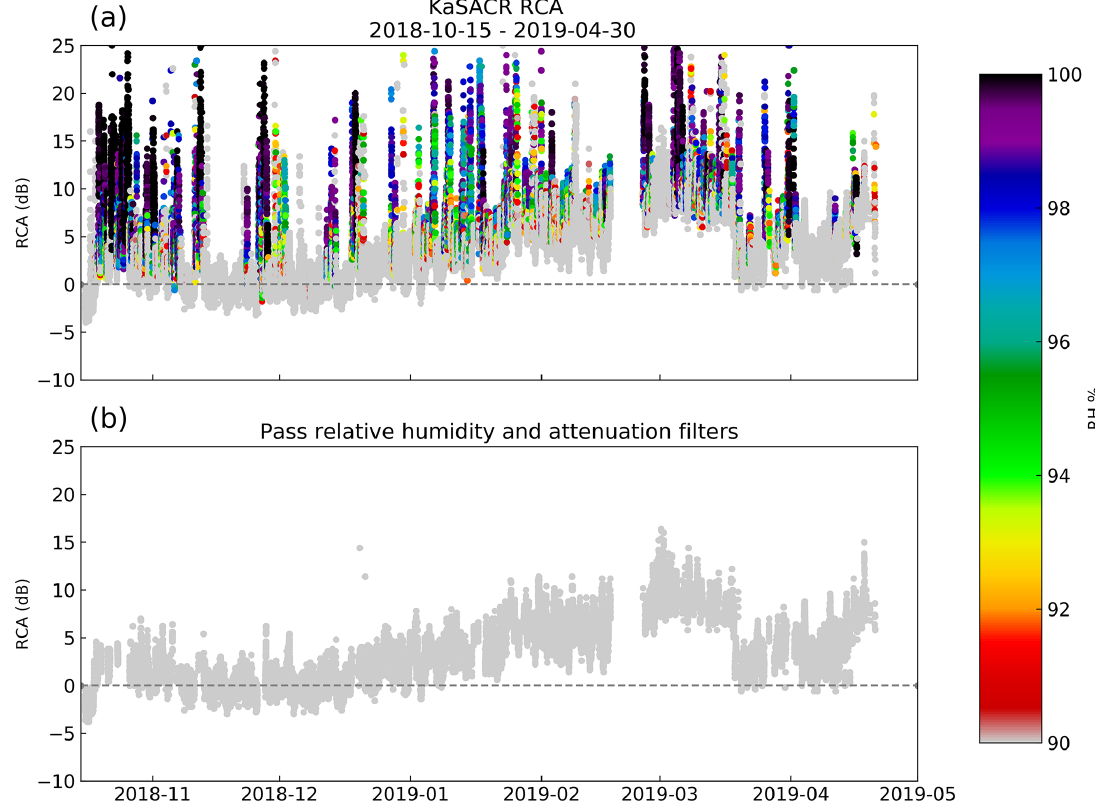
Figure 17. Panel (a) shows the sub-daily (per file) RCA values without any pre-filtering for the CACTI field campaign. Color indicates relative humidity, with gray as the threshold at 90%. Significant variability is present on days with higher relative humidity. The sub-daily values after filtering for attenuation and 90% relative humidity are shown in (b) . Filtering reduces the variability in the data, allowing for a clear trend to be